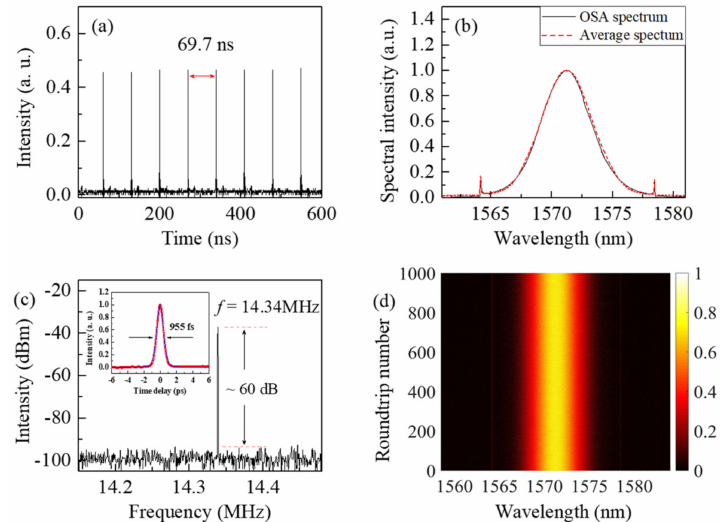
Figure 2. Single-soliton state. ( a ) Pulse train, ( b ) OSA-measured optical spectrum (black curve) and the average (red dashed curve) of the DFT single-shot spectra, ( c ) corresponding RF spectrum (inset shows the autocorrelation trace), and ( d ) shot-to-shot spectra of 1000 roundtrips.